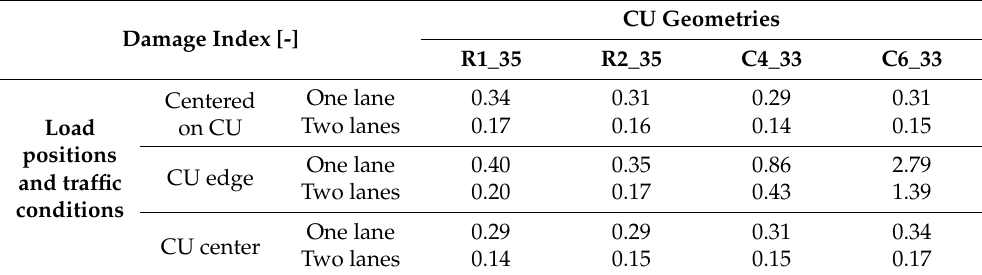
Table 9. Damage Index DI considering two traffic